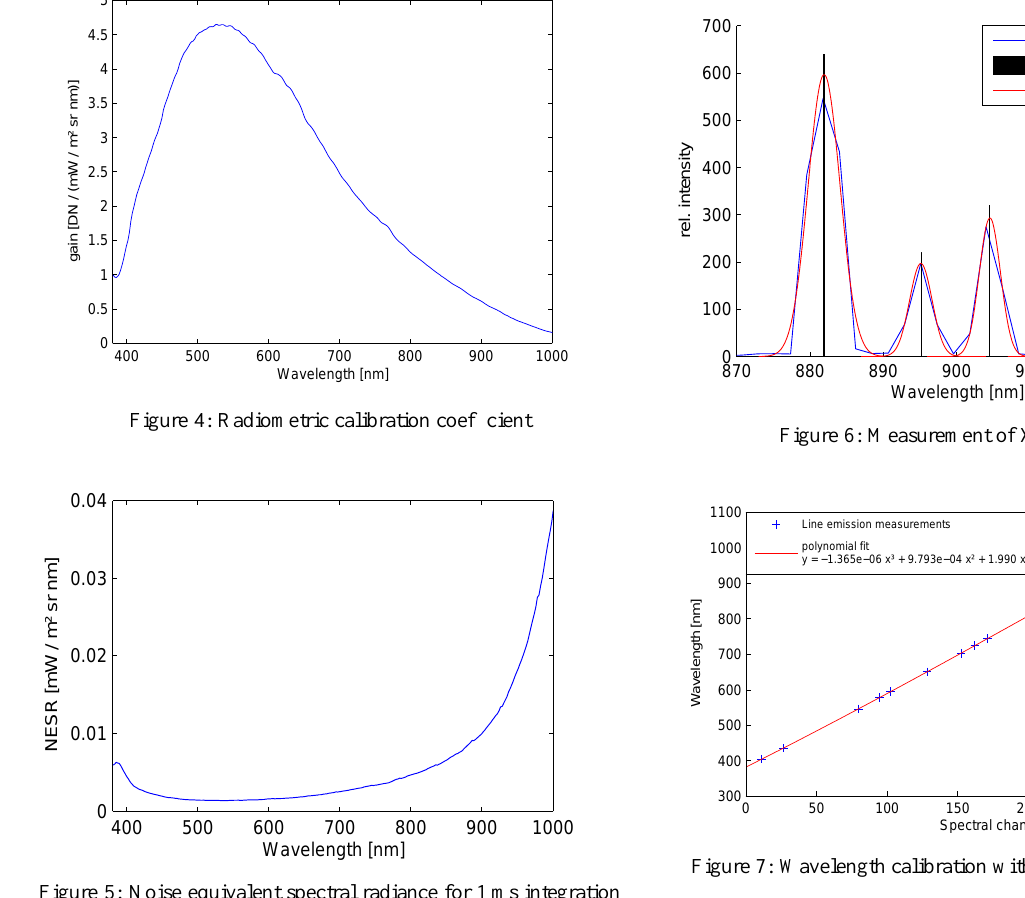
Figure 5: Noise equivalent spectral radiance for 1 ms integration time